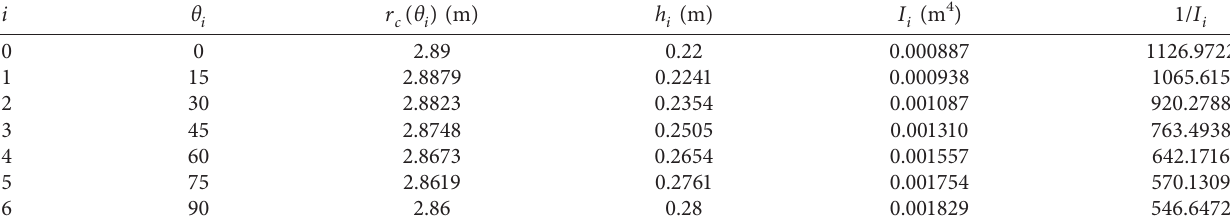
Table 3: Geometric data and calculated parameters of the stepped